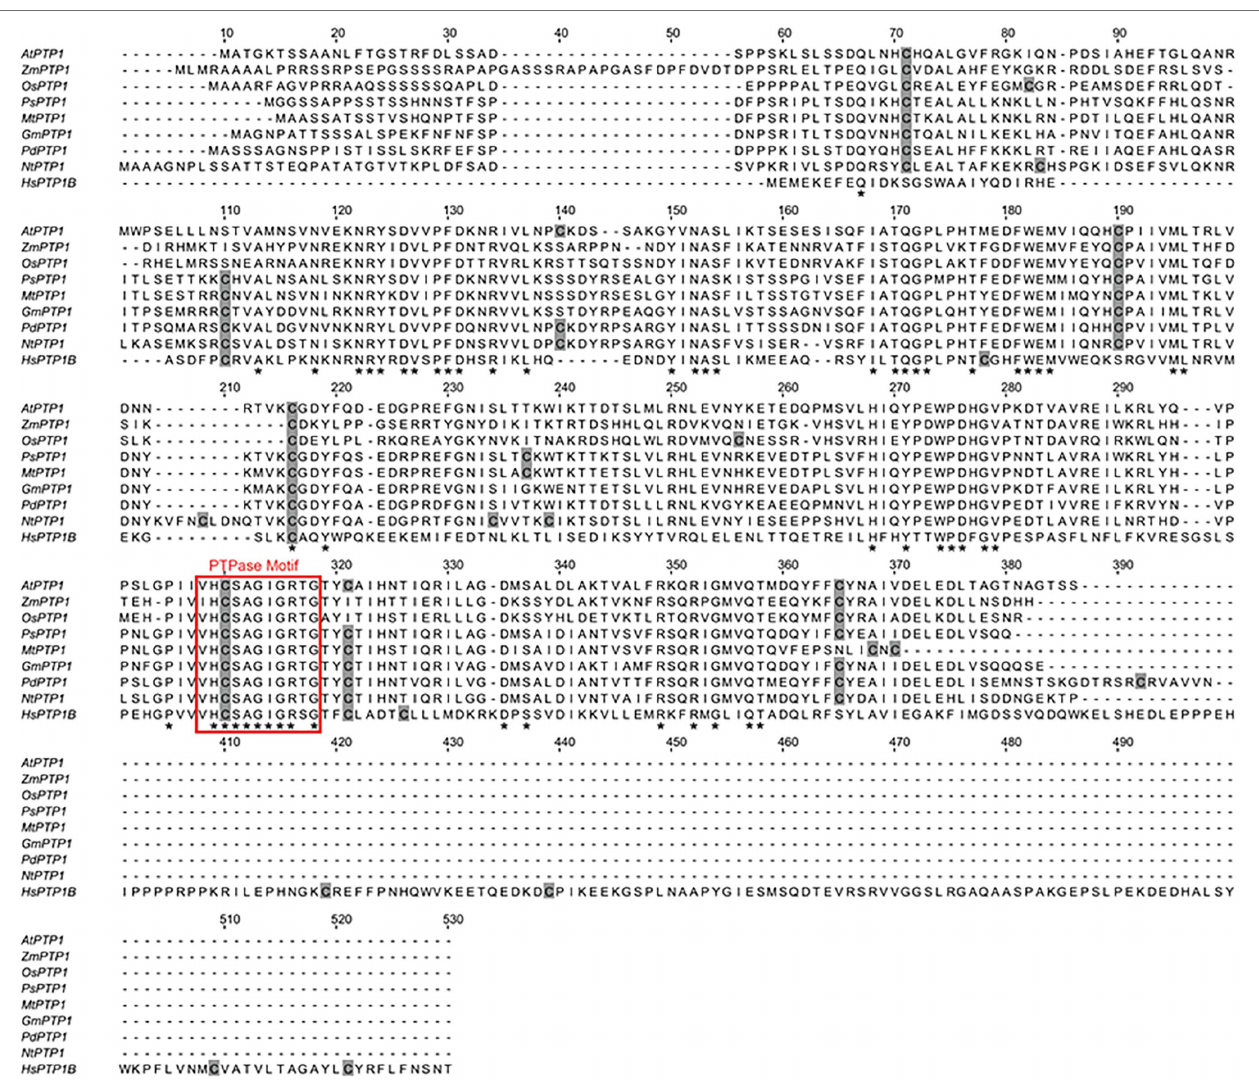
modification after His- At PTP1 treatment either with GSH or GSNO was reported on Figure 2B for S-biotinylation, on Supplementary Figure S1A for S-methylthiolation and on Supplementary Figure S1B for S-glutathionylation. The GSNO- treated His- At PTP1 control condition, without the addition of HPDP-biotin, showed that none of the peptides were found to be biotinylated under this condition, thus ensuring that the His- At PTP1 protein was not biotinylated during its synthesis in the bacteria and that the observed biotinylation results from the application of the biotin switch method (data not shown). In contrast, methylthiolated and biotinylated forms were detected for all seven Cys-containing peptides. Nevertheless, the presence